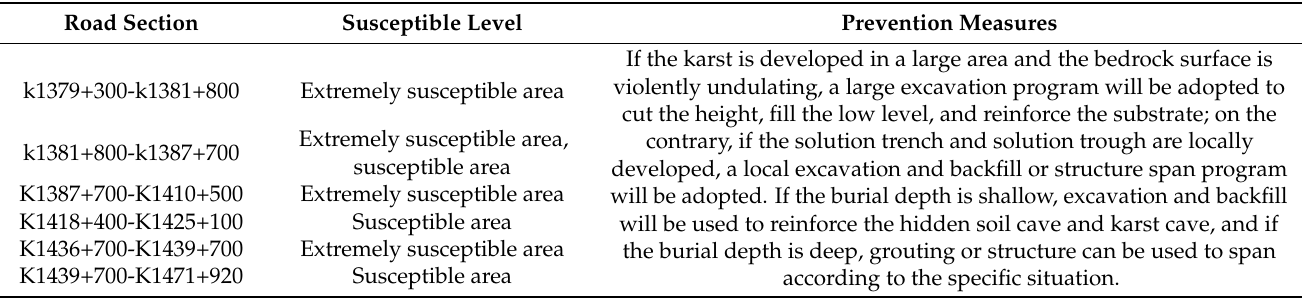
Table 8. Table of prevention